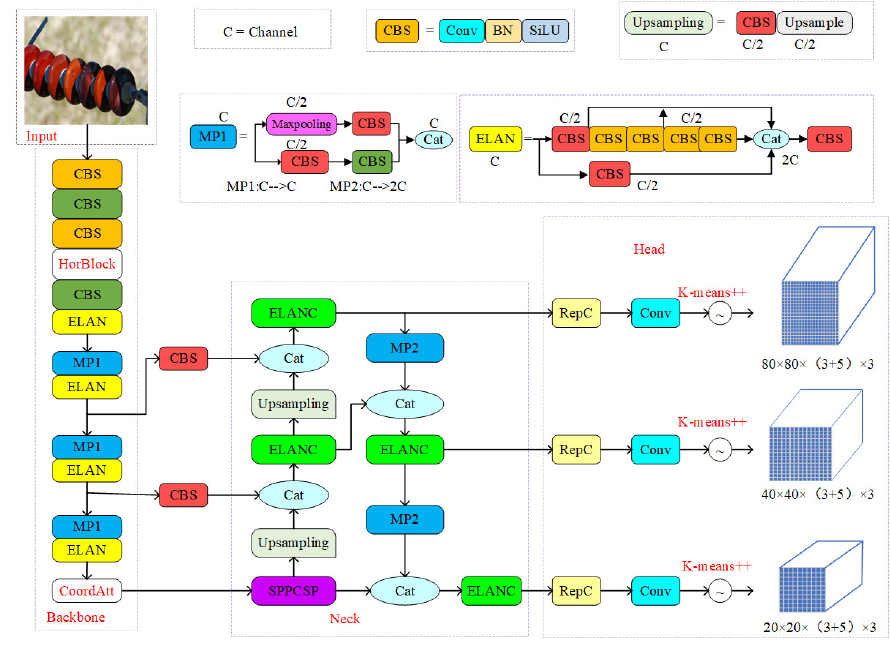
Figure 5. Structure of the improved YOLOv7